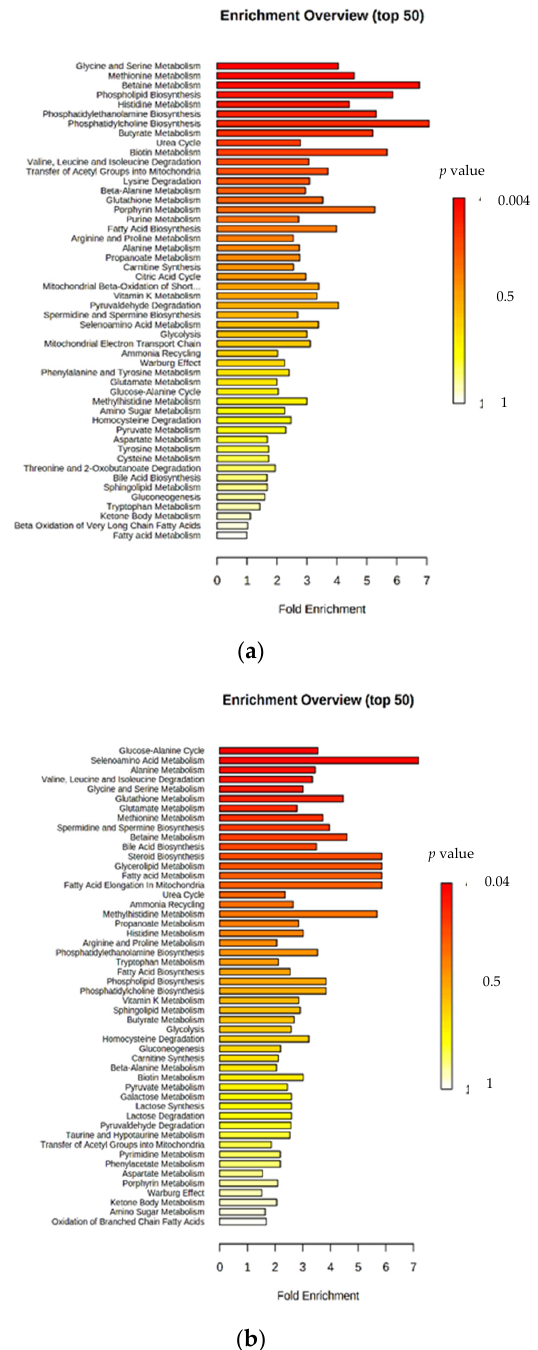
Figure 5. Summary plots for quantitative enrichment analysis at ( a ) − 8 weeks and ( b ) − 4 weeks before calving.